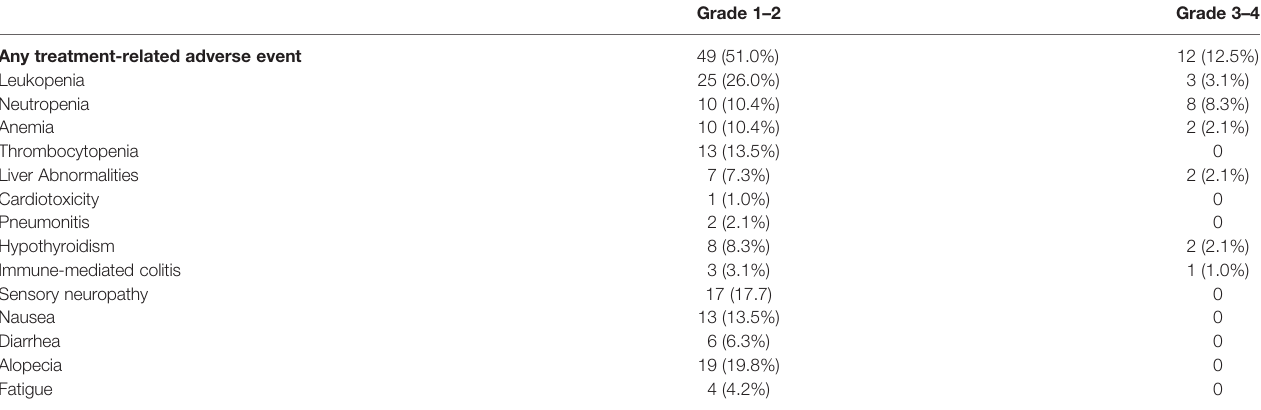
TABLE 5 | Treatment-related adverse